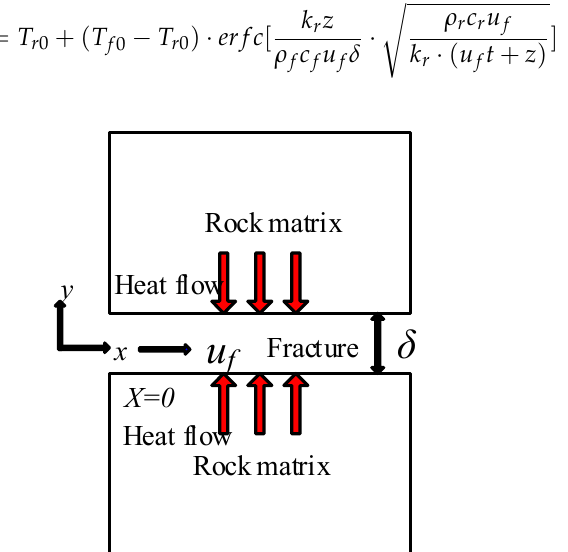
Figure 2. Heat transfer diagram of two-dimensional single fracture model. Table 2. Main material parameters of single fracture model.